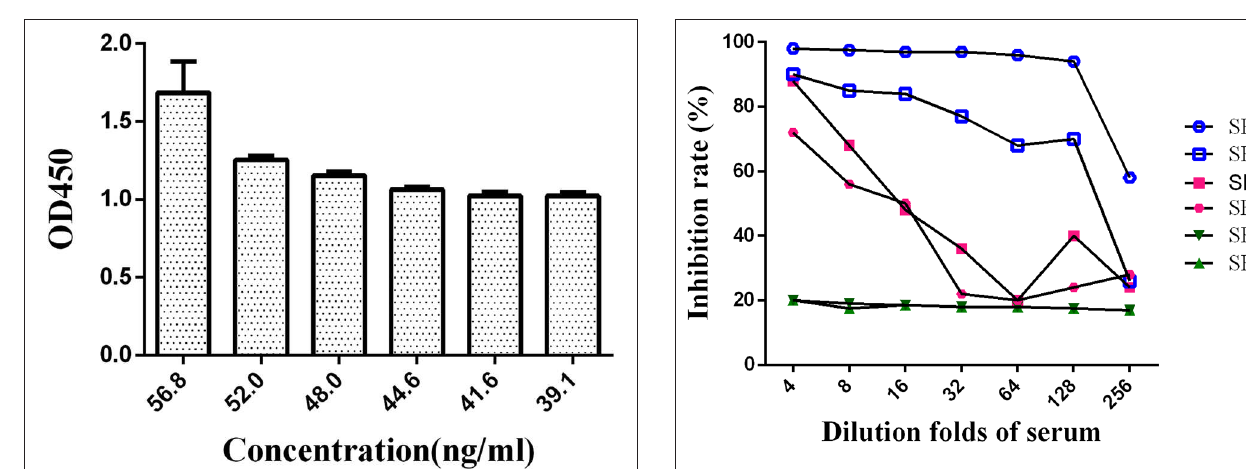
FIGURE 5 | Optimization of positive serum dilution. (SE, SE2: serum by Salmonella enteritidis 1, 2; SP1, SP2: serum by Salmonella pullorum 1, 2; SPF1, SPF2: serum from SPF chickens).